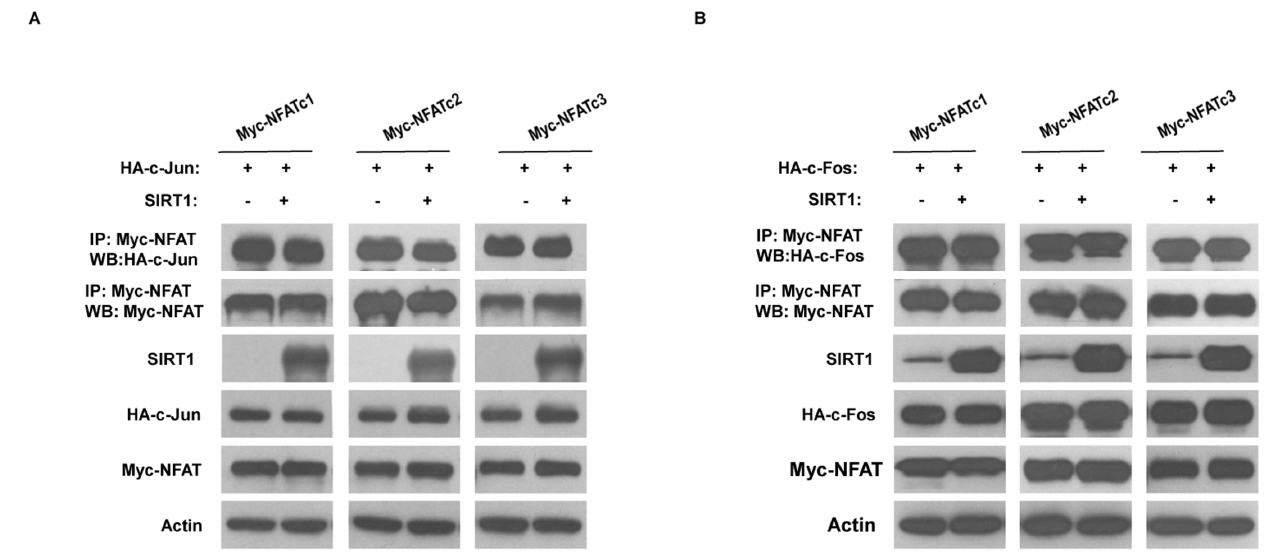
Figure 4. SIRT1 does not interfere the interaction between NFAT and c-Jun or c-Fos. (A) HEK293 cells were transfected with the HA-tagged c-Jun, Myc-tagged NFAT, either SIRT1 or control (pcDNA3.1) vectors for 24 h. Myc-tagged NFAT was then immunoprecipitated and c-Jun was assessed by western blotting using anti-HA antibody. The images are representative of three independent experiments. (B) Similar studies were performed using HA-tagged c-Fos. The images are representative of three independent